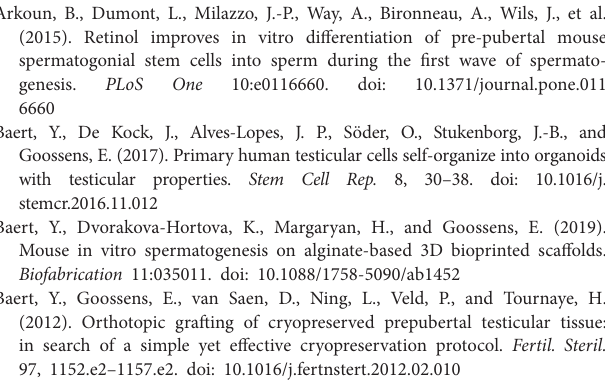
Supplementary Figure 2 | Characterization germline stem (GS) cell and two-layer scaffold (2LS) cultures. (A,B) GS colonies on a MEF feeder exhibiting EGFP fluorescence (B) . (C) Flow cytometric analysis of EGFP expression in the GS cell culture before mixing with primary testicular